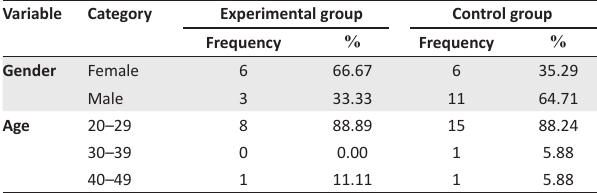
TABLE 1: Biographical characteristics of